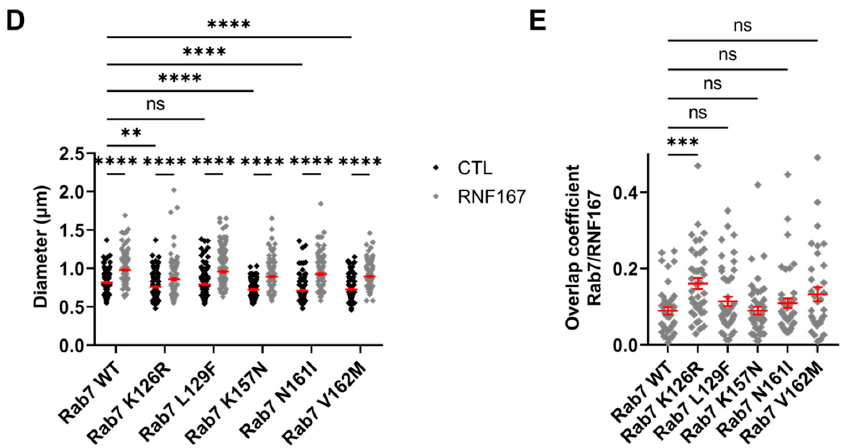
Figure 6. Charcot–Marie–Tooth Type 2B variants of Rab7 impair RNF167-mediated ubiquitina- tion . ( A ) Schematic representation of Rab7 polypeptide linear structure and amino acid residues substituted in CMT2B variants. Blue, GTPase domain; green, magnesium binding region; orange, guanine binding region. Letters in red are amino acid residues substituted in CMT2B. ( B ) Evaluation of Rab7 CMT2B variant ubiquitination. HEK293T cells were transfected with plasmids encoding the indicated proteins and lysed for immunoprecipitation with GFP antibody. Immunoblot against UB evaluated Rab7 ubiquitination. Blots are representative results of two separate experiments. ( C ) HeLa cells were transfected with the indicated constructs and fixed for immunofluorescence against HA-tag (Rab7, green) and V5-tag (RNF167, purple). Scale bar = 10 µm and 2 µm for zoom image. Images are representative results of three separate experiments. ( D ) Measurement of vesicle diam- eter of Rab7 CMT2B variants. The diameters of the five largest vesicles positive for both Rab7 and RNF167 signals were measured for each cell. CTL = control. Two-way ANOVA with Tukey’s post hoc test was used on the dataset collected from three independent experiments, totaling 38 to 54 cells corresponding to 190–270 vesicles analyzed. Errors bars (red) represent mean ± SEM, ns = non- significant, **, p = 0.0026, ****, p < 0.0001. ( E ) Manders’ overlap coefficient analysis between Rab7 and RNF167. Non-parametric one-way ANOVA Kruskal–Wallis test was used. Errors bars (red) repre- sent mean ± SEM, n = 30–42 cells, ns = non-significant, ***, p = 0.0002.